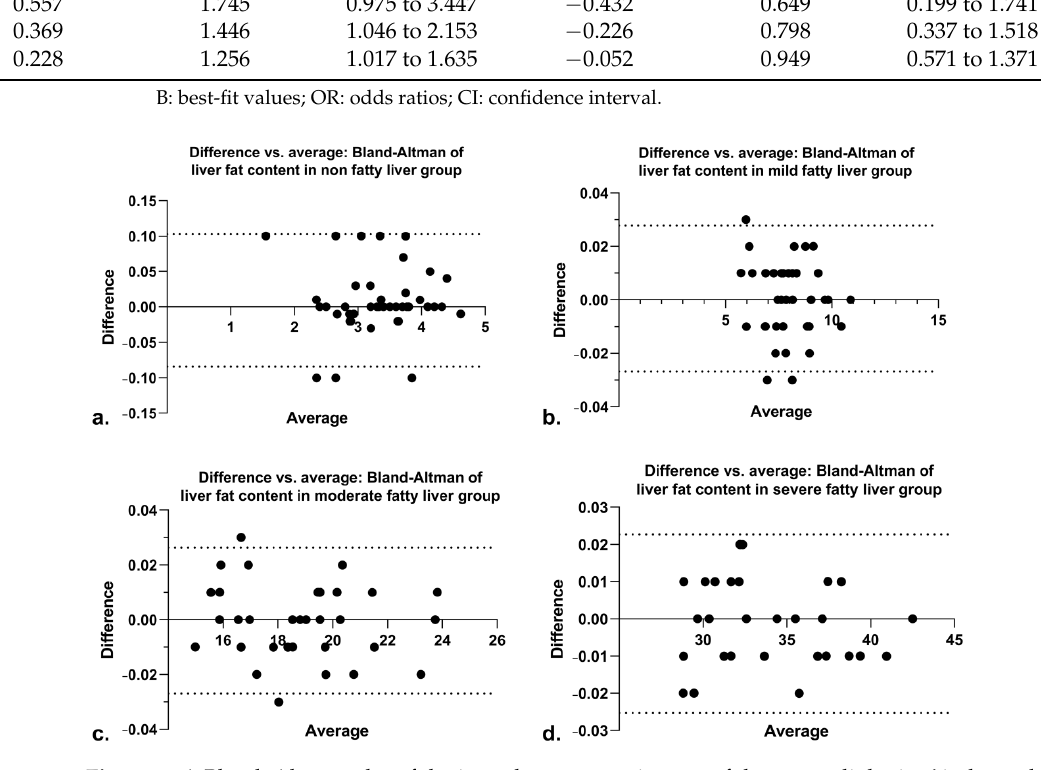
Figure 3. A Bland–Altman plot of the interobserver consistency of the two radiologists’ independent measurements of the liver fat content of the non-( a ), mild( b ), moderate( c ), and severe( d ) fatty liver groups. The 95% limits of agreement for the four groups were − 0.08433 to 0.103, − 0.02684 to 0.02784, − 0.02696 to 0.02639, and − 0.02533 to 0.02266, respectively, indicating high interobserver consistency.